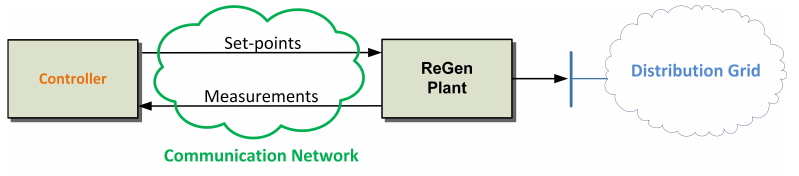
Figure 2. Basic NCS architecture for distributed online voltage coordination.